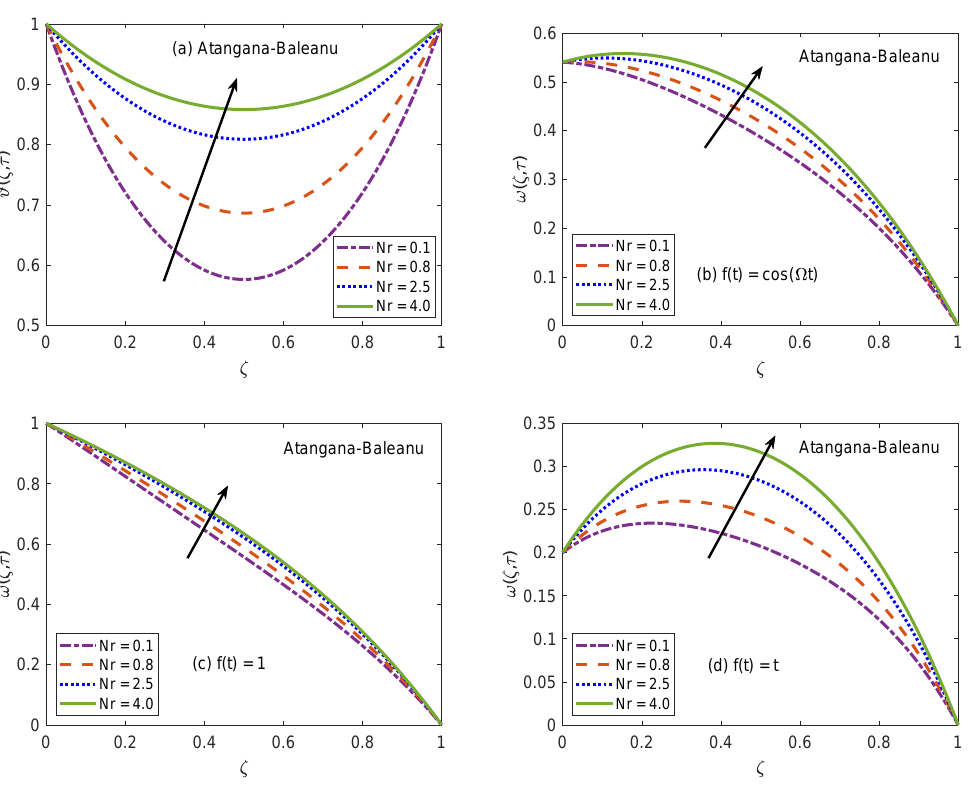
Figure 8. Temperature and velocity patterns of AB model for variation of Nr .